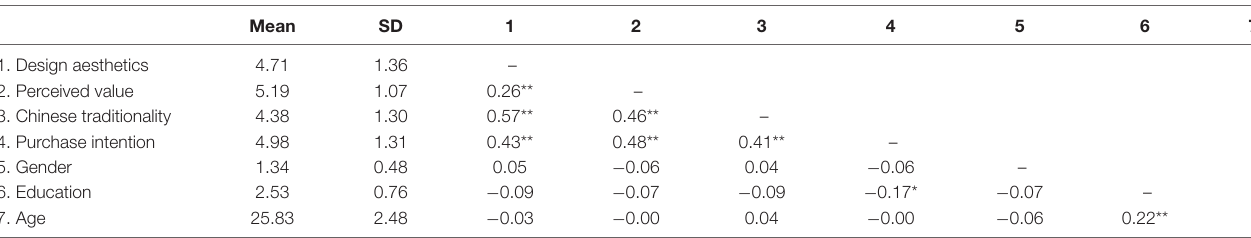
TABLE 2 | The means, standard deviations, and correlations among the study variables.